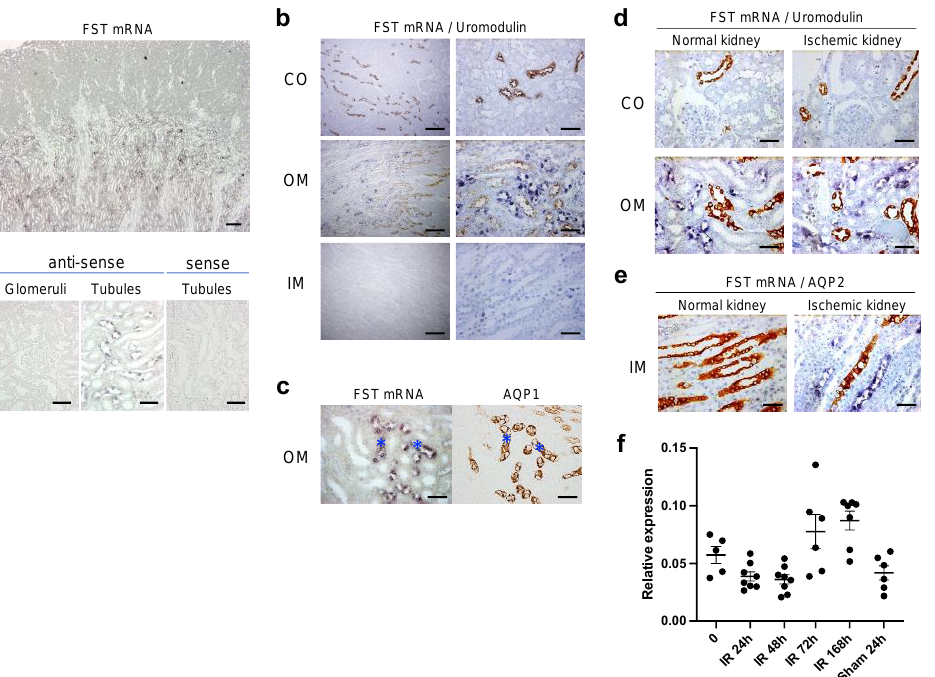
Figure 3. Expression and localization of follistatin mRNA in normal and ischemic rat kidneys. ( a ) Localization of follistatin mRNA in normal kidneys was examined by in situ hybridization. Hybridization signals are shown as blue color. Bar = 0.2 mm (left panel), 50 µ m (right panels). ( b ) Follistatin mRNA (blue) and uromodulin (brown) in normal kidneys was evaluated by double staining. Cortex, CO; outer medulla, OM; inner medulla, IM. Bar = 0.2 mm (left panel), 50 μm (right panels). ( c ) Localization of follistatin mRNA and aquaporin 1 (AQP1) in normal rat kidneys was evaluated using serial sections. Asterisks indicate identical tubules. ( d ) Follistatin mRNA (blue) and uromodulin (brown) in normal and ischemic kidneys at 24 after reperfusion was evaluated by double staining. Cortex, CO; outer medulla, OM. ( e ) Follistatin mRNA (blue) and aquaporin 2 (AQP2, brown) in normal and ischemic kidneys was evaluated by double staining. Inner medulla, IM. Bar = 50 μm in ( c – e ). ( f ) Quantitative analysis of follistatin mRNA expression by real-time PCR. Values (relative expression ratio to GAPDH) are means ± S.E. ( n = 5 – 8).